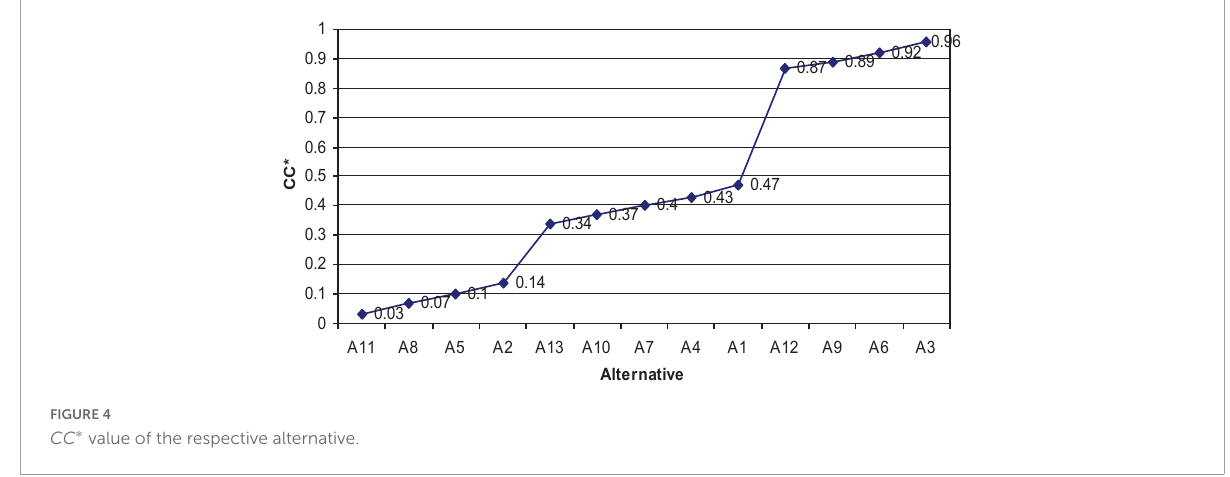
FIGURE4 CC ∗ value of the respective alternative.